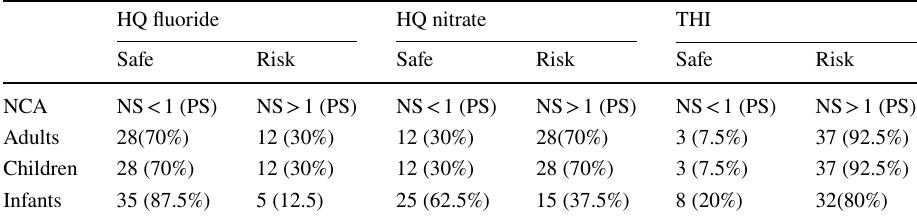
Table 8 Assessment of non- carcinogenic risk of adult, children, and infants based on total hazard index